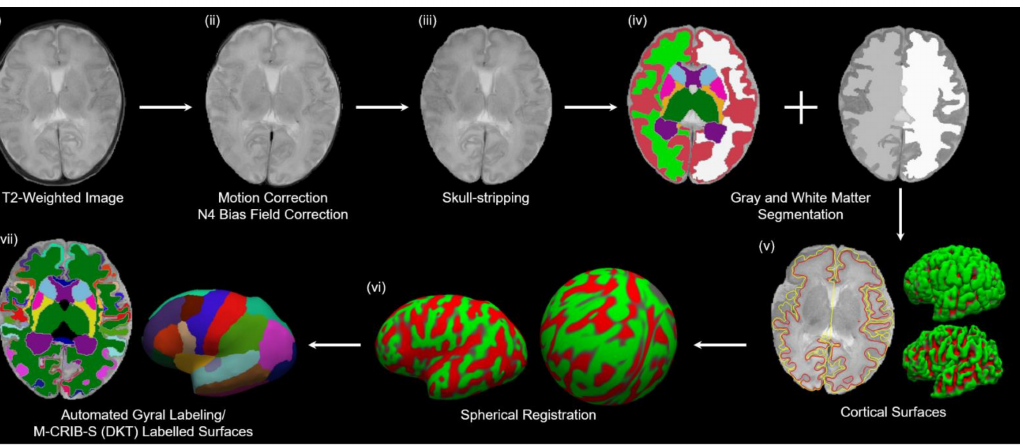
Figure 2. Flowchart of image processing. ( i ) The original T2-weighted image; ( ii , iii ) preprocessing of the T2-weighted image; ( iv ) automatically segmented regions (cerebral gray and white matter, cerebellum, and subcortical gray matter); ( v ) extracted cortical surfaces. The left panel exhibits outer (yellow), and inner (red) cortical surfaces overlaid onto the native image. The right-top and right-bottom panels show a lateral view of the left hemisphere outer and inner surfaces; ( vi ) inflated and the spherical surfaces of the white-matter surfaces; ( vii ) automated gyral parcelation using the M-CRIB-S neonate